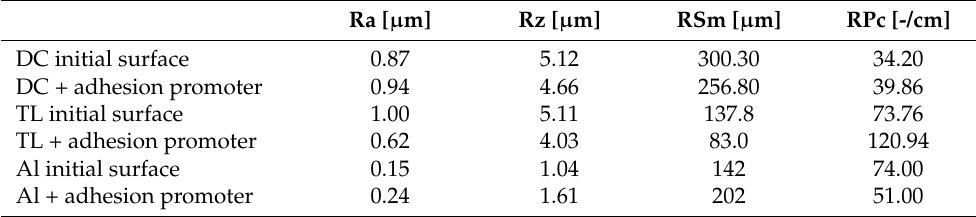
Table 7. Selected parameters of surface